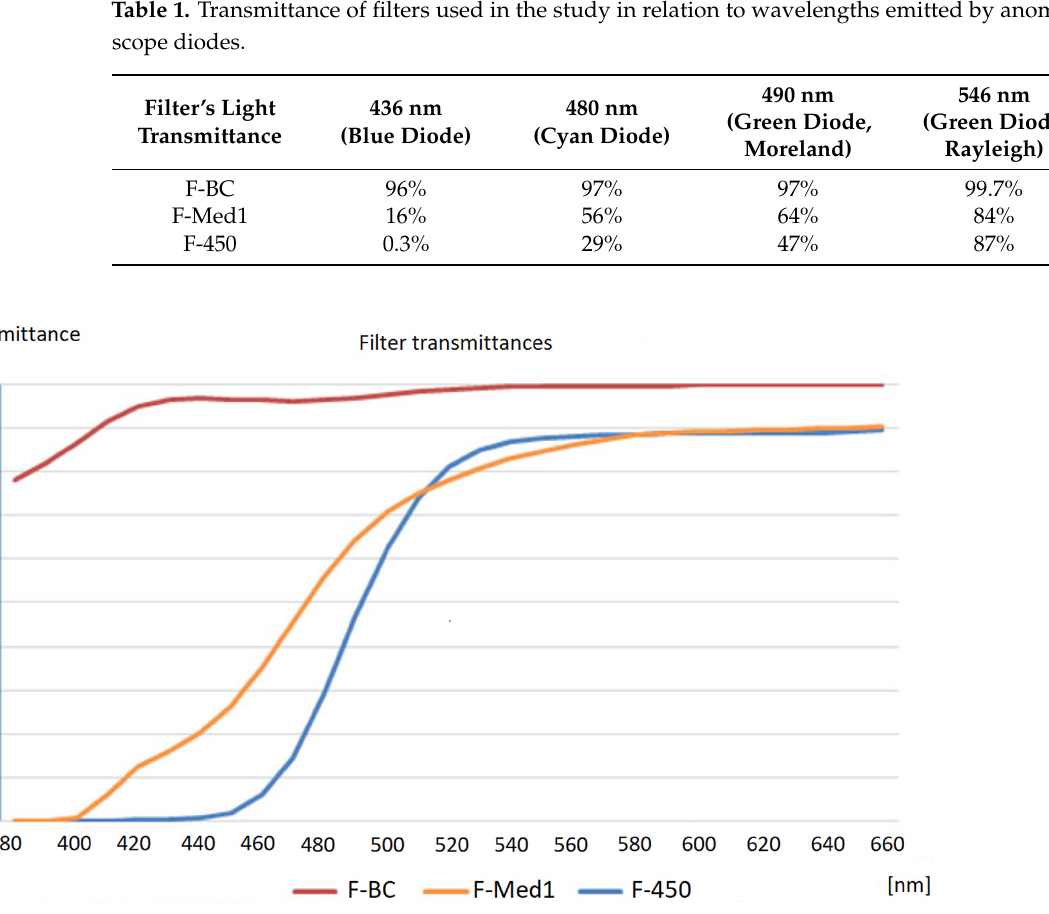
Figure 1. Characteristics of the filters used in this study: F-450 (Eschenbach), F-BC Blue Control (Hoya) and F-Med1 (JZO). Table 1. Transmittance of filters used in the study in relation to wavelengths emitted by anomalo- scope diodes.